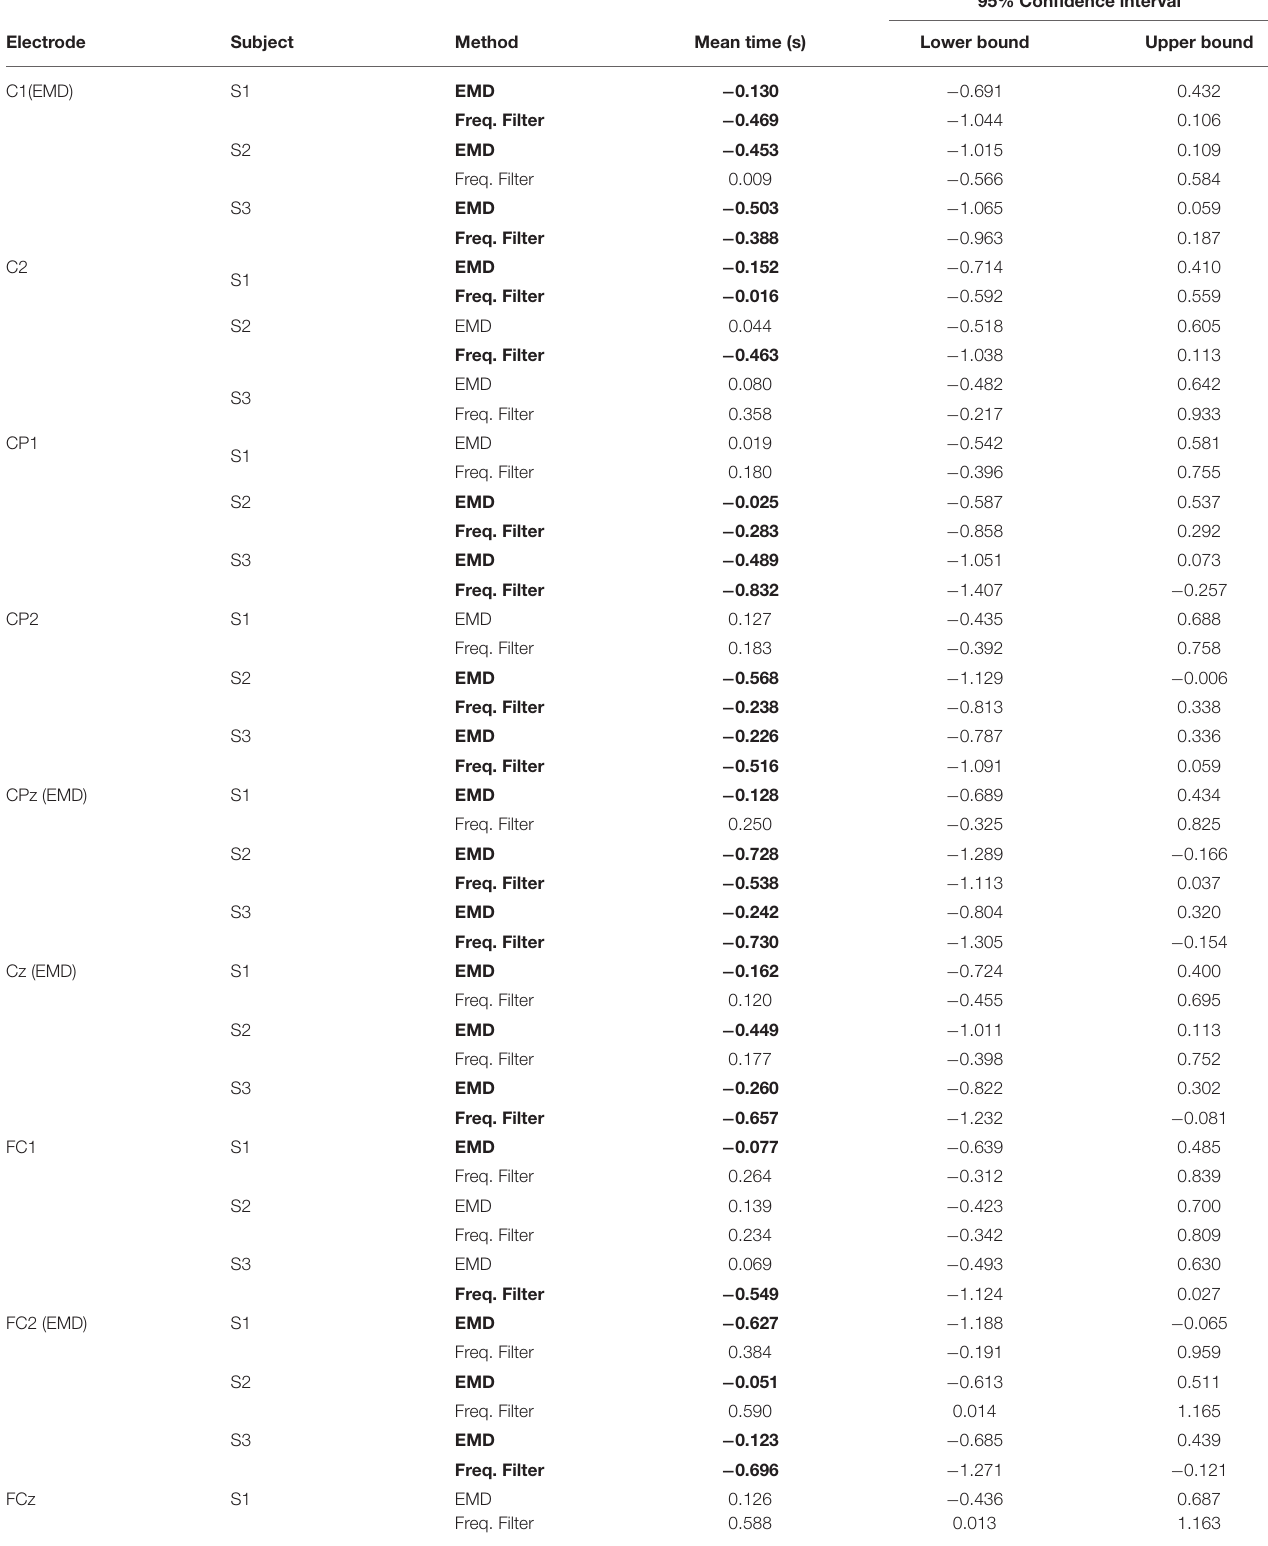
TABLE 4 | Comparison between IMF3 and the signal filtered between 8 and 15 Hz for the detection time of gait